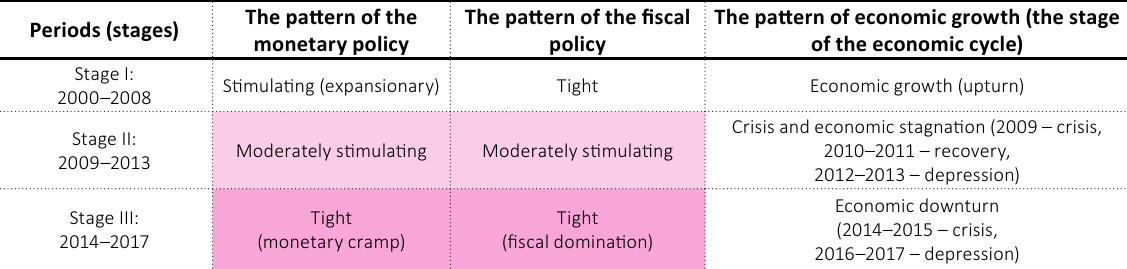
Table 2. The stages of the implementation of monetary and fiscal policies in Ukraine in